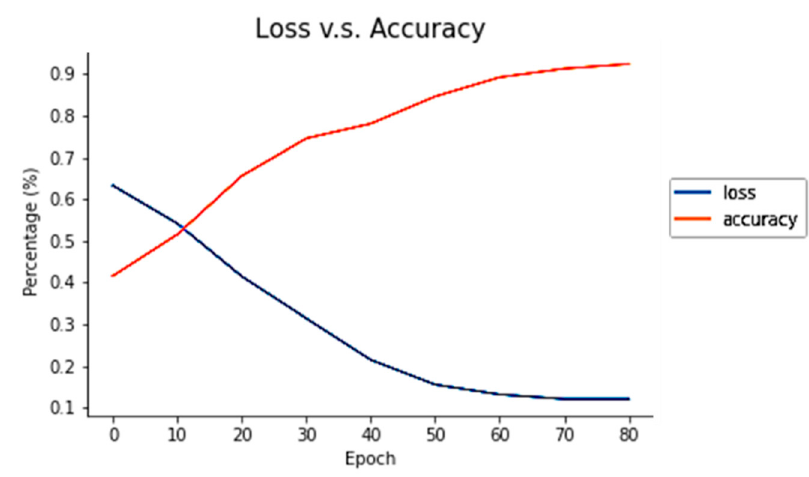
Figure 19. Loss and accuracy in training phase of DD-BLSTM model.